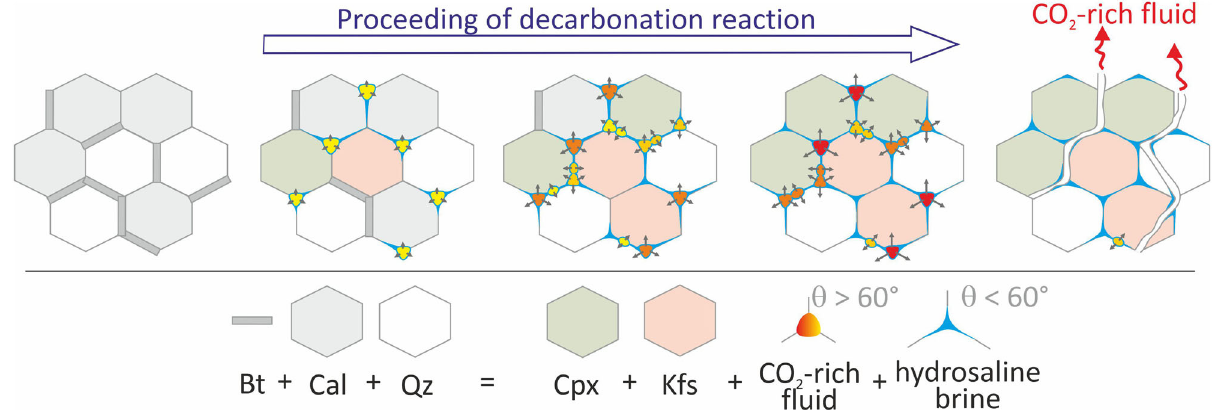
Fig. 5 Sketch illustrating fl uid production and evolution at the proceeding of a decarbonation reaction (Bt + Cal + Qz = Cpx + Kfs + fl uid), which occurs at a depth of 25 – 30 km (i.e., at P – T conditions compatible with event II). Two immiscible fl uids are generated in the source rocks: the CO 2 -rich fl uid is shown in yellow-red, with colors changing from yellow to red according to the progressive increase of the fl uid pressure within the pores, whereas the hydrosaline brine is reported in blue. The short to long black arrows radiating from the CO 2 - fi lled pores indicate the progressive increase of the fl uid pressure in the pores. The dihedral angles of the two fl uids (CO 2 -rich fl uid: θ > 60°; hydrosaline brine: θ < 60°) imply that the CO 2 -rich fl uid accumulates within isolated fl uid pockets, whereas the hydrosaline brine forms thin interconnected fi lms along grain edges. As far as the decarbonation reaction proceeds, fl uid pressure within the CO 2 -rich pockets increases until fl uid overpressure is reached, carbo-fracturing the host rocks. The CO 2 -rich fl uid